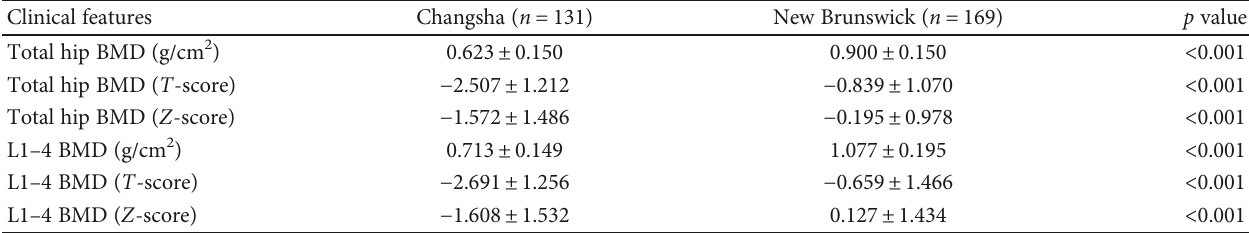
Table 3: Comparison of BMD of PHPT patients in New Brunswick and Changsha from 2010 to 2016. Clinical features